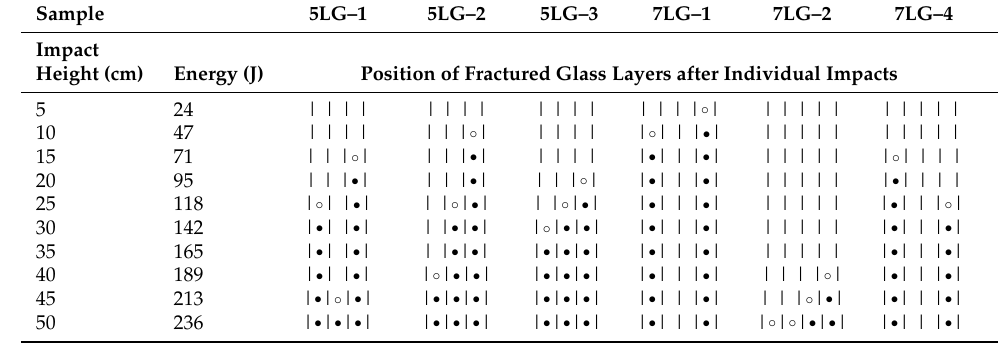
Table 2. Overview of fractured glass layers after individual impacts including impact energies. With the left-hand side impacted, the symbols | | indicate the previously fractured glass layers, empty • spaces | | the unfractured ones, and circles | | the crack initiation in a glass layer. ◦ Sample 5LG–1 5LG–2 5LG–3 7LG–4 Impact Height (cm) Energy (J) Position of Fractured Glass Layers after Individual